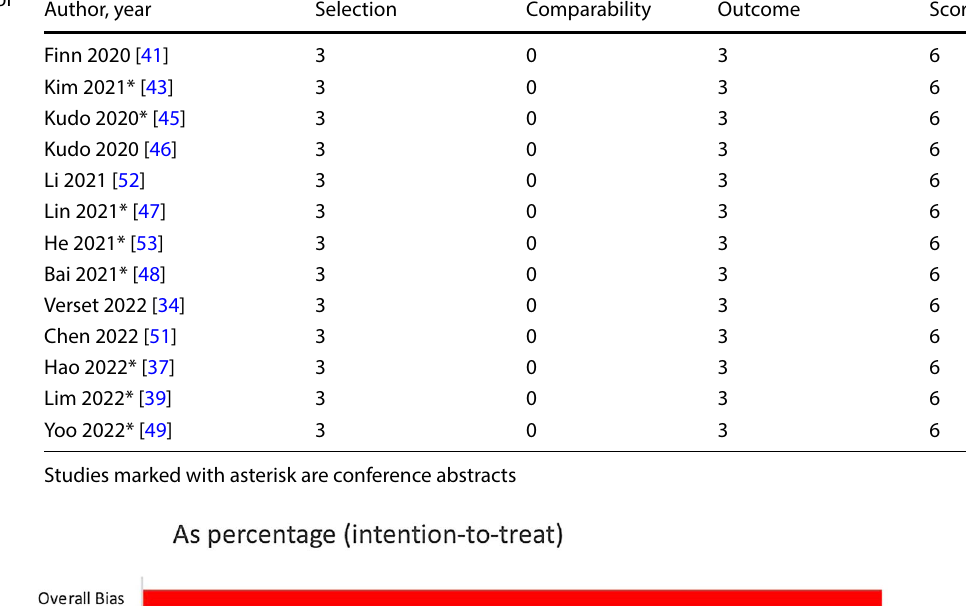
Table 3 Quality assessment of single-arm clinical trials